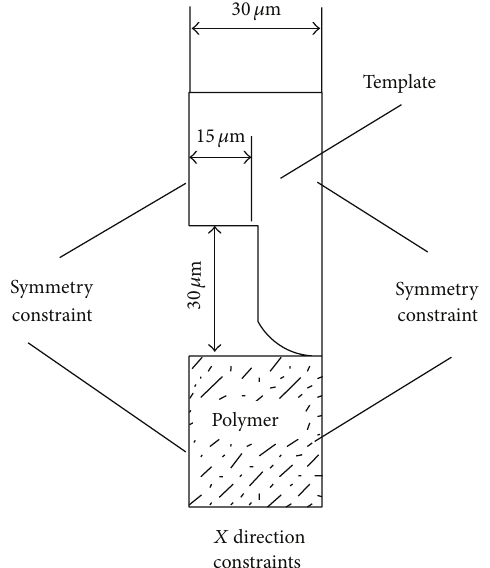
Figure 4: Overall distribution of the strain at the decreased distances of 15, 30, 45, and 60 𝜇